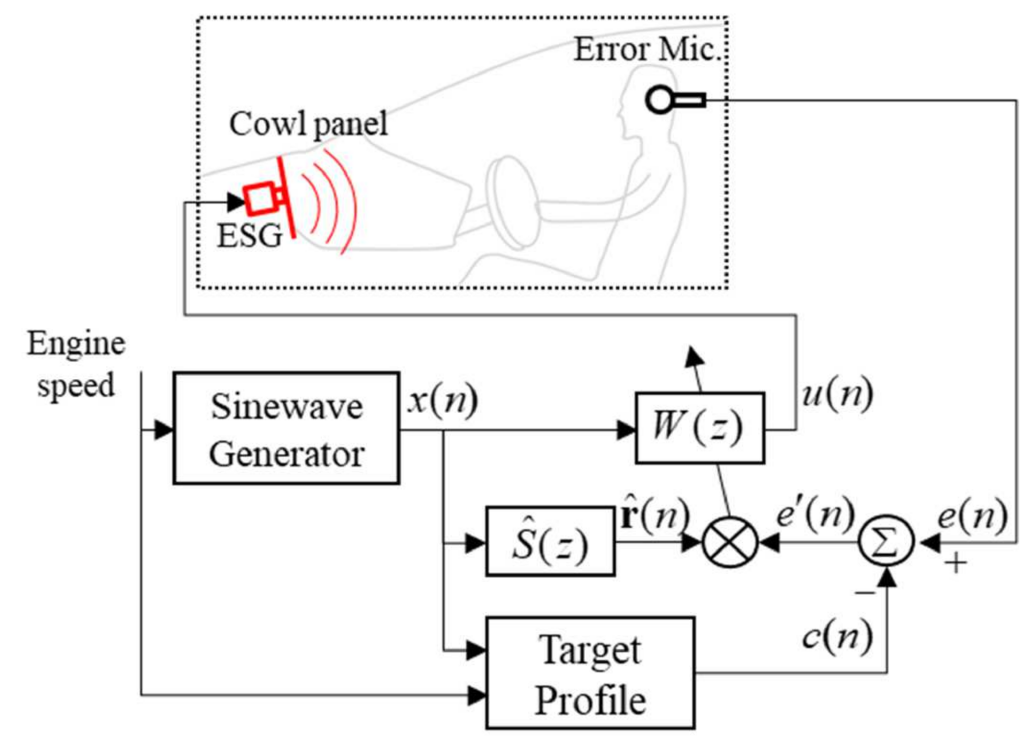
Figure 1. Block diagram of the pure ASP control algorithm based on the